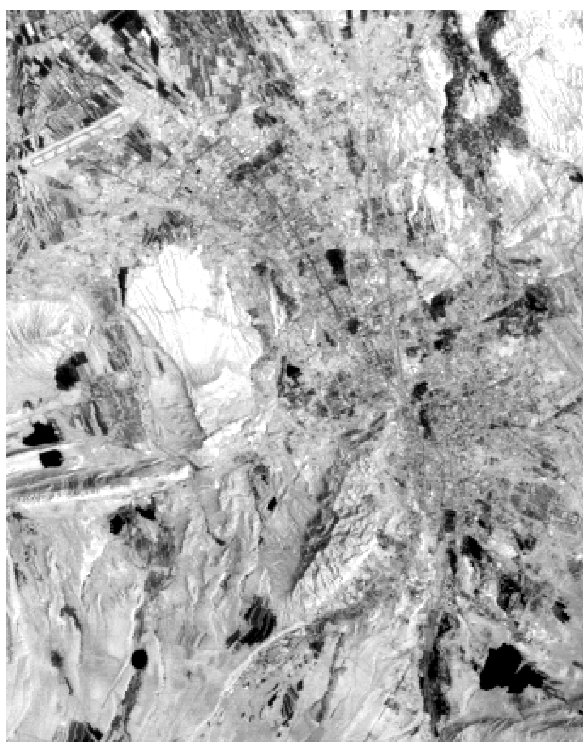
Figure 3 Thermal band image of Urmqi. Based on the values of digital count number for the thermal image shown in Figure 3 corresponding to each class, We have seen that the temperature of urban area was higher than that of vegetation area.